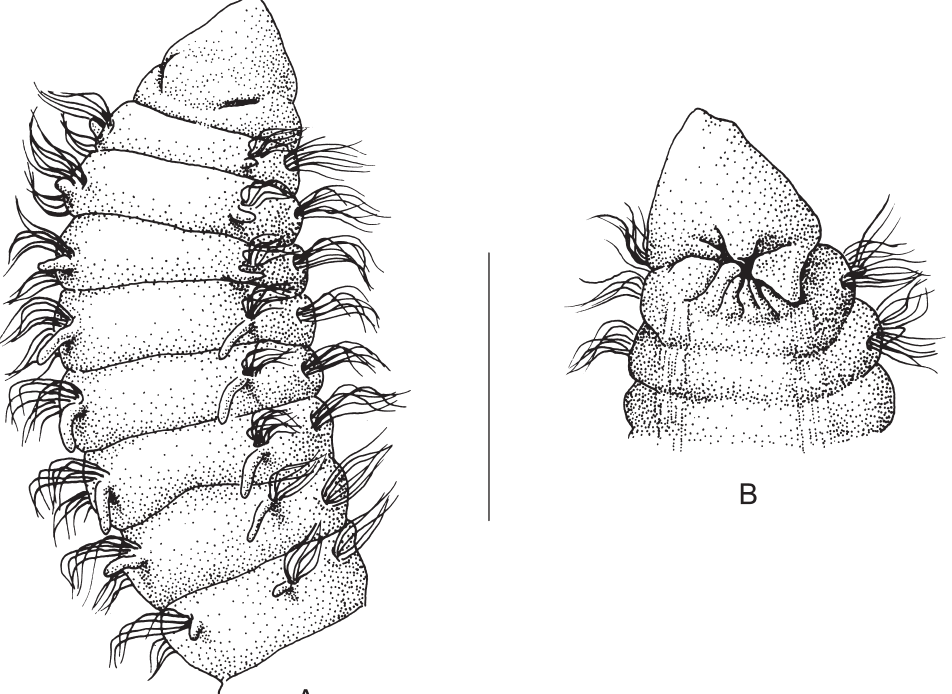
Fig . 7. – Paraonides myriamae : A, anterior region, dorsal view; b, anterior region, ventral view. Scale bar: A 265 µ m; b 250 µ